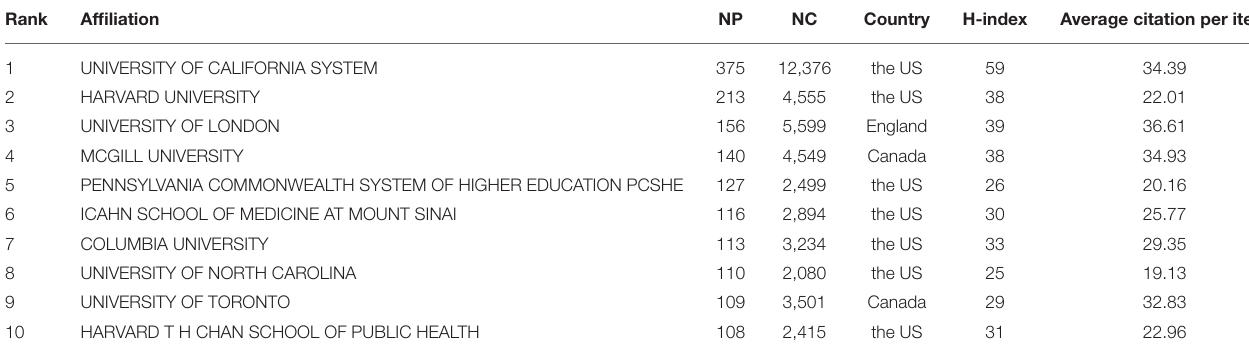
TABLE 2 | Top 10 productive